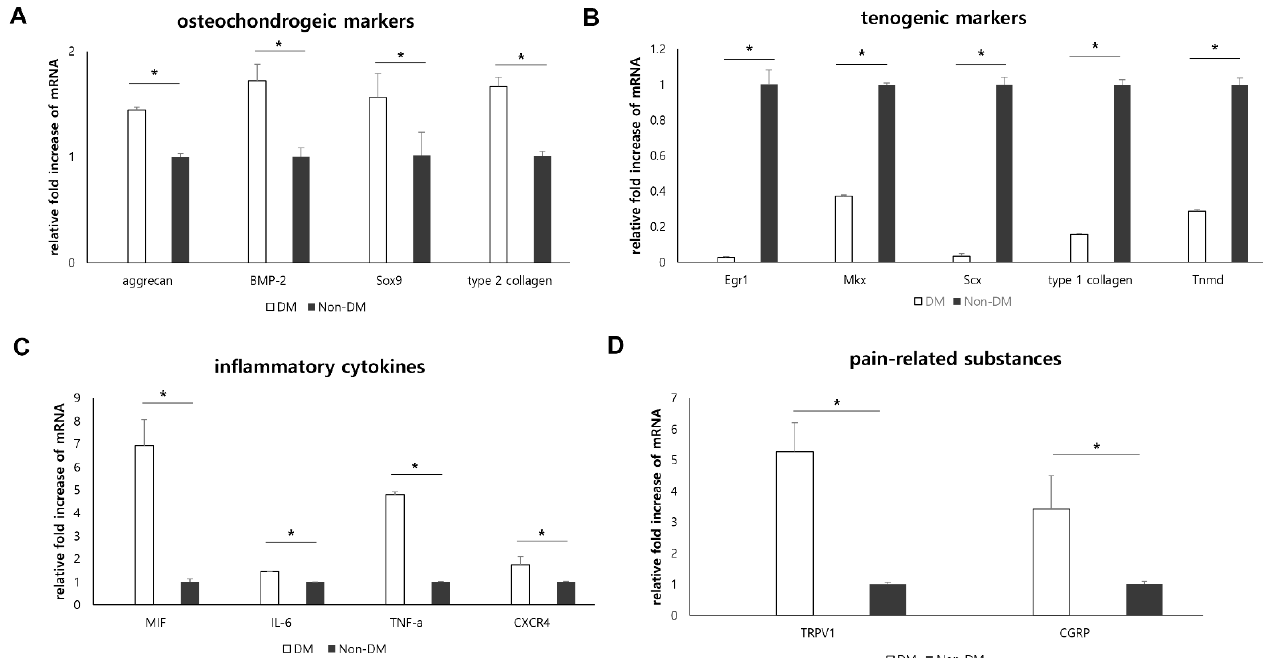
Figure 2. Effect of diabetes on the mRNA expression levels of osteochondrogenic markers, tenogenic makers, inflamma- tory cytokines, and pain-related substances in supraspinatus tendons in vivo. Changes in mRNA expression levels of ( A ) osteochondrogenic differentiation markers (aggrecan, bone morphogenic protein (BMP)-2, Sox9, and type 2 collagen), ( B ) tenogenic differentiation markers (Egr1, Mkx, Scx, type 1 collagen, and tenomodulin (Tnmd)), ( C ) inflammatory cytokines (macrophage migration inhibitory factor (MIF), interleukin (IL)-6, tumor necrosis factor (TNF)- α , and CXCR4, and ( D ) pain-related substances (calcitonin gene-related peptide (CGRP) and transient receptor potential vanilloid 1 (TRPV1)) in diabetic (DM) and non-DM groups. The mRNA expression levels of the target genes were normalized to that of the GAPDH gene. *: statistical significance between the diabetic (DM) and non-DM groups.